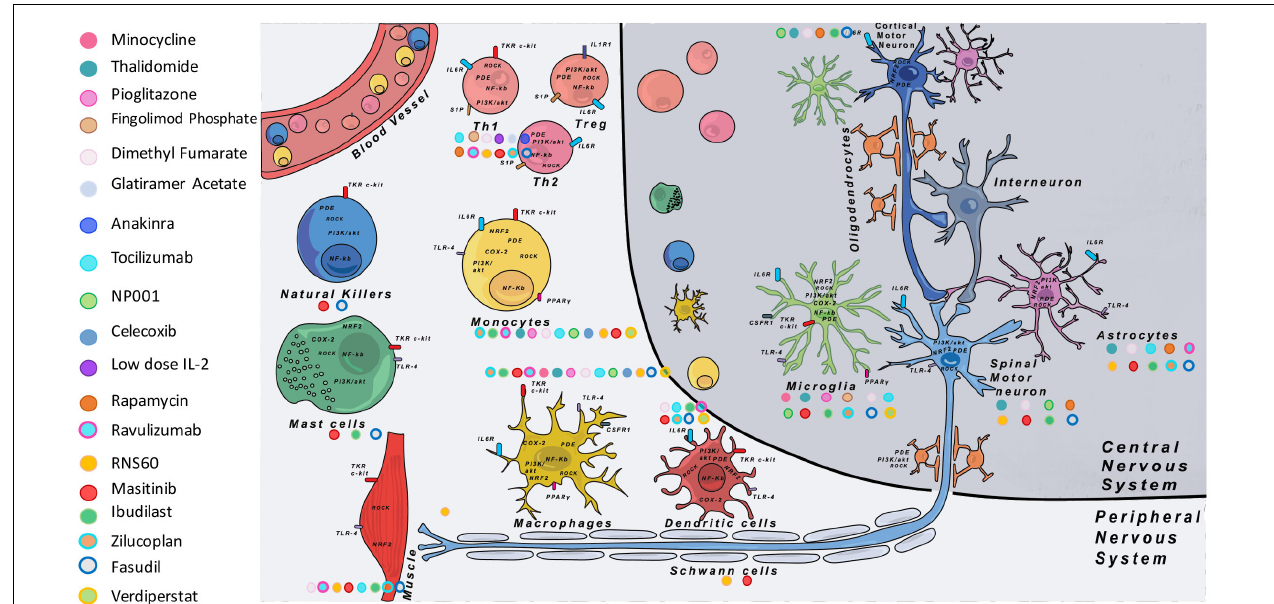
FIGURE 2 | Main immune modulatory molecules tested in ALS clinical trials. On the left are listed the different tested molecules with their corresponding colors. On the figure each color dot next to the different cell types shows on which cell the immune modulatory drug is supposed to have an effect. Some cell types targeted by the drugs were well studied in the literature (see Table 4 ), but in some cases we completed data with theoretical targets (depending on the expression of the target on specific cell types indexed with proteinatlas.org, and for which no information in the literature was found). COX-2, cyclooxygenase-2; CSF1R, colony stimulating factor 1 receptor; IL-1R1, interleukin 1 receptor 1; IL-2, interleukin-2; IL-6R, interleukin 6 receptor; NF- κ B, nuclear factor kappa-light-chain-enhancer of activated B cells; NRF2, nuclear factor erythroïd-2-related factor 2; PDE, phosphodiesterase; PGE2, prostaglandin E2; PI3K, phosphoinositide 3-kinase; PPAR γ ,